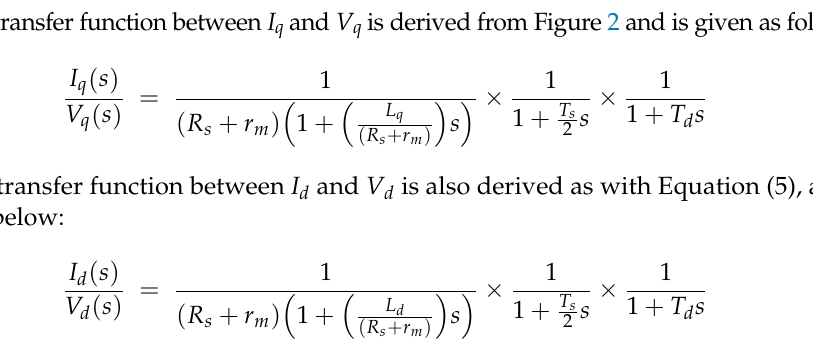
Figure 2. Closed-loop system diagram of inner current control in Q-axis.